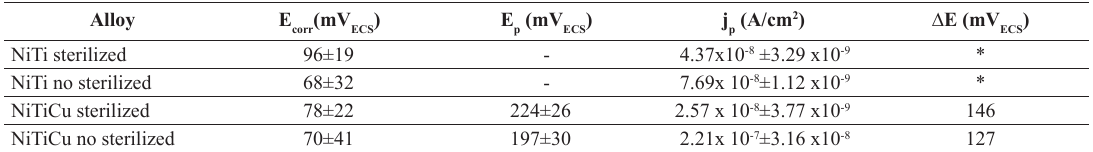
Figure 4. SEM images of NiTi (a,b,c) and NiTiCu (d,e,f) raw material before (a,b) and after polarization of no sterilized group (b,e) and of sterilized group Table 2. Parameters obtained from polarization curves of wires for sterilized conditions.